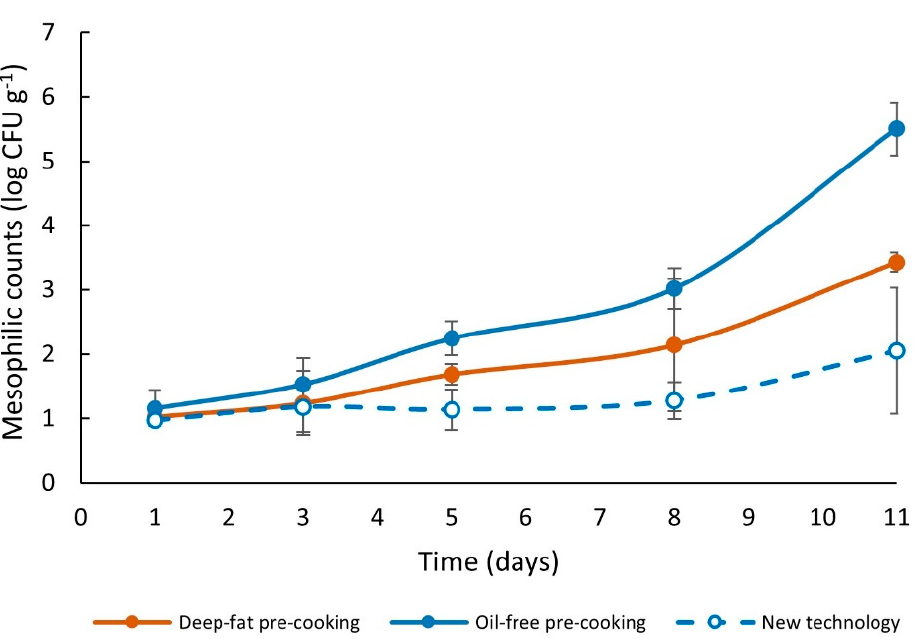
Figure 8. Mesophilic loads (log CFU g − 1 ) of pre-cooked (different methods) chicken nuggets stored up to 11 days at 4 °C (n = 3 ± SD).